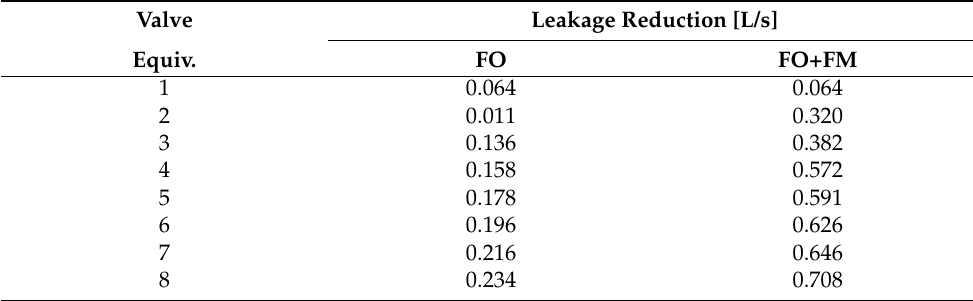
Figure 3. Resulting Pareto plot from example zone (no. 106) in Trondheim’s WDN. Table 1. Expected (Pareto) optimal leakage reduction achieved for alternative number of valve equivalents for example zone (no.